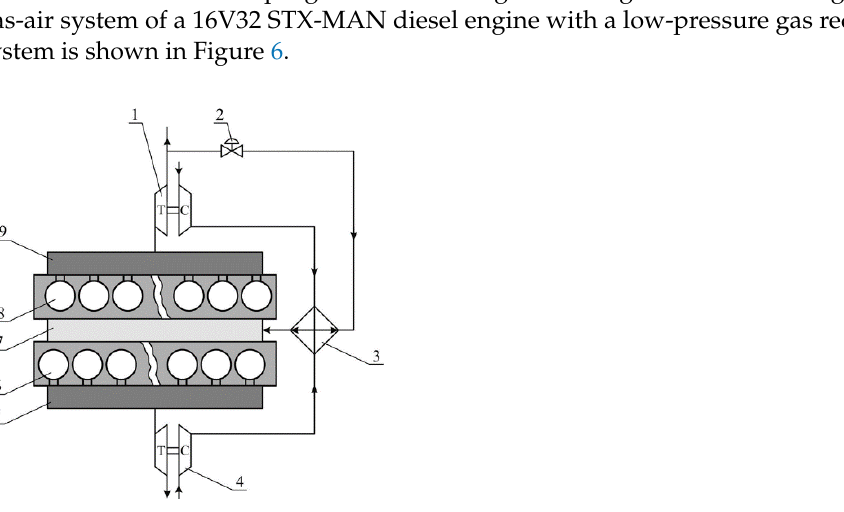
Figure 5. Drillships near a semi-submersible drilling rig.